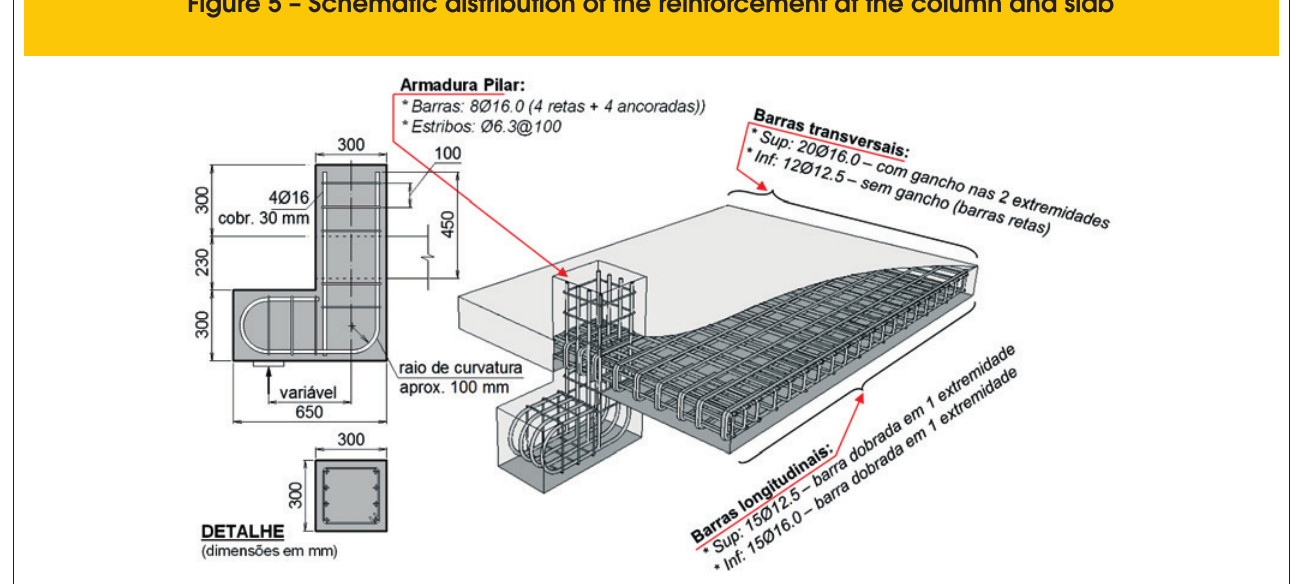
Figure 5 – Schematic distribution of the reinforcement at the column and